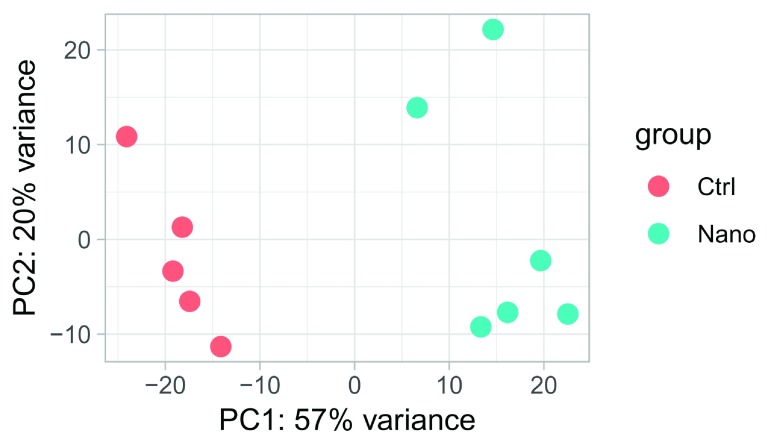
PCA-plot of batch corrected expression.